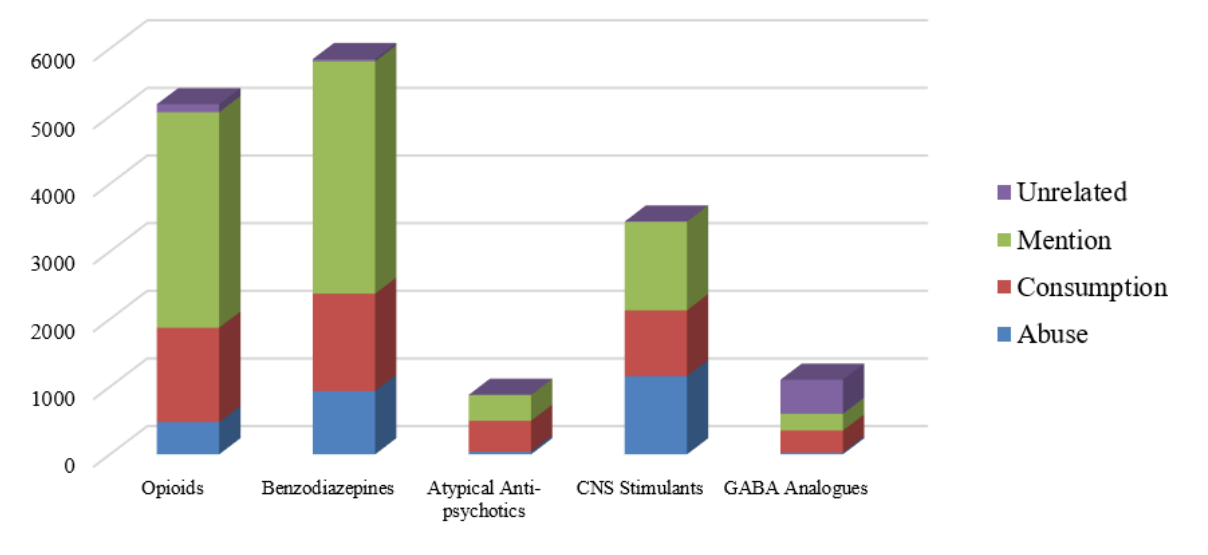
Figure 2. Distribution of tweets in the annotated corpus by annotation category and drug class.